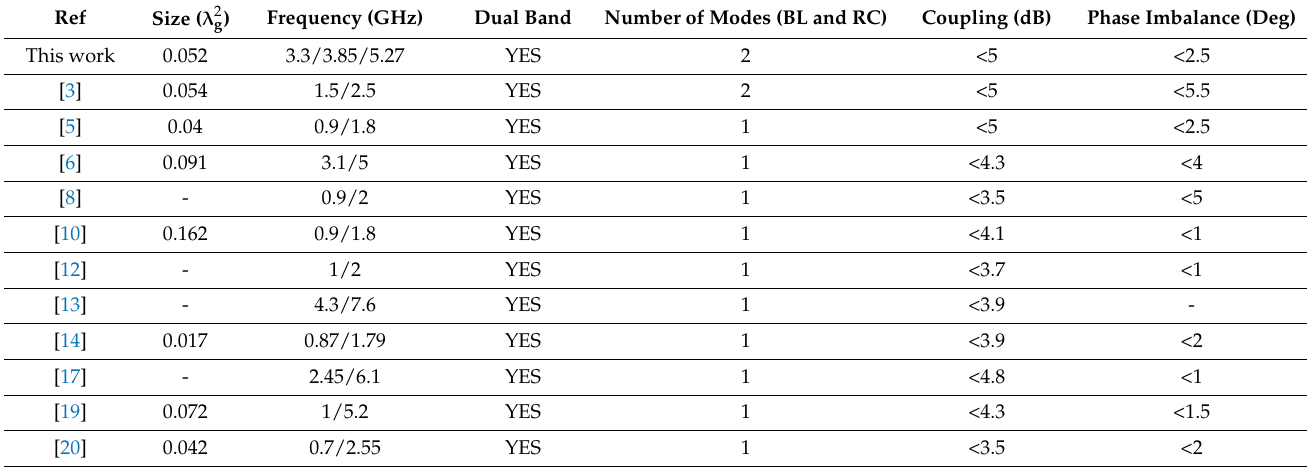
Table 2. A comparison between the proposed coupler and other